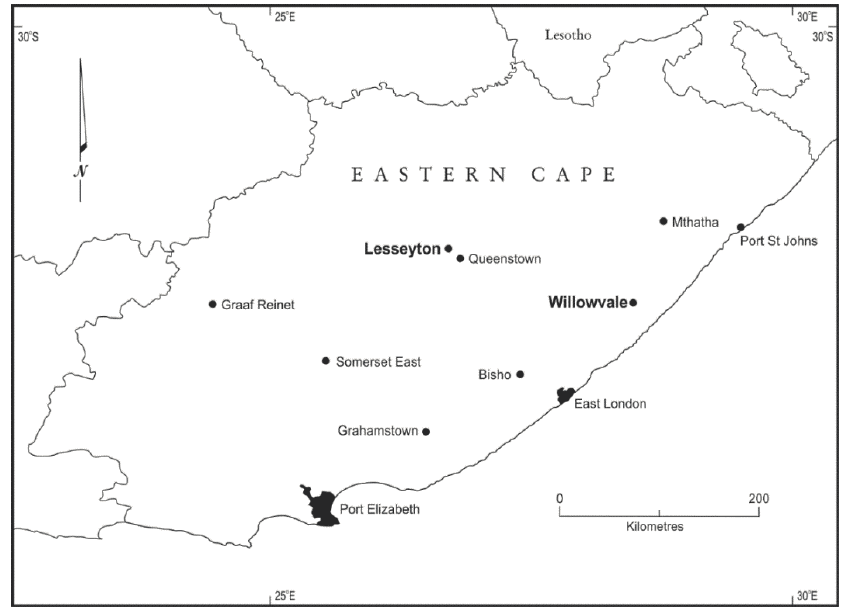
Figure 1. Map of the Eastern Cape, South Africa showing study